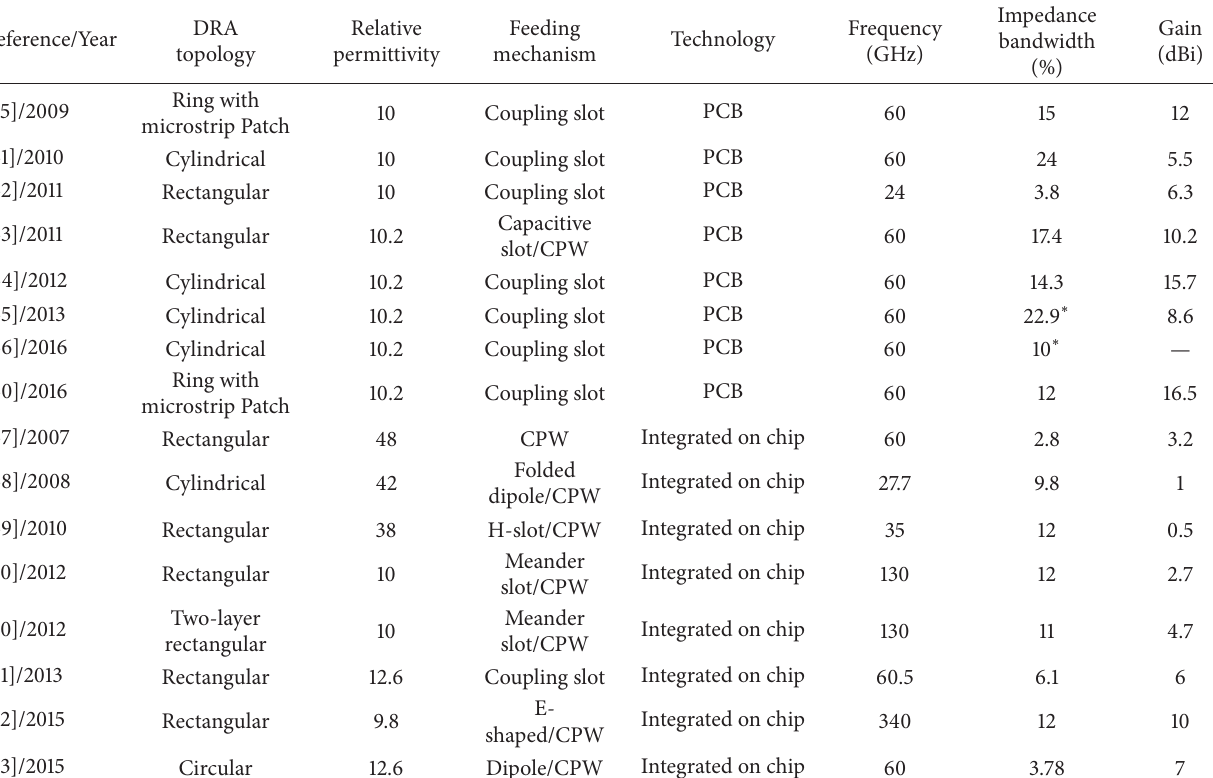
Figure 26: Top view (a) and cross-sectional view (b) of a hybrid ring/patch DRA as introduced in [55]. Table 6: Most Recent Advances in dielectric resonator antennas for millimeter-wave